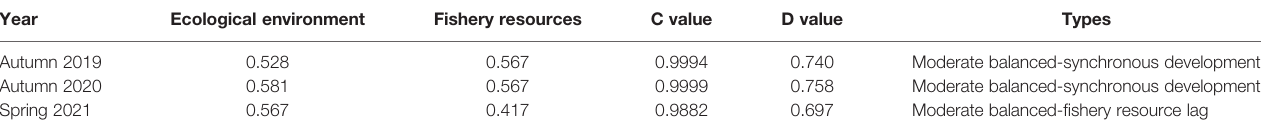
TABLE 6 | Coupling and coordination degree of marine ecological environment and fi shery resources in Dachen